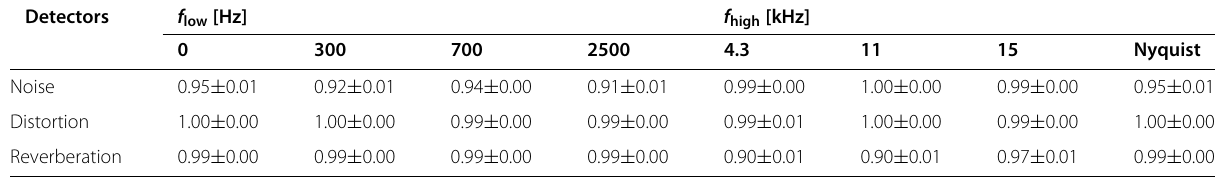
Table 5 The impact of changing the lower and higher cutoff frequencies of the log-mel spectrogram on the performance of each detector for normal running speech signals